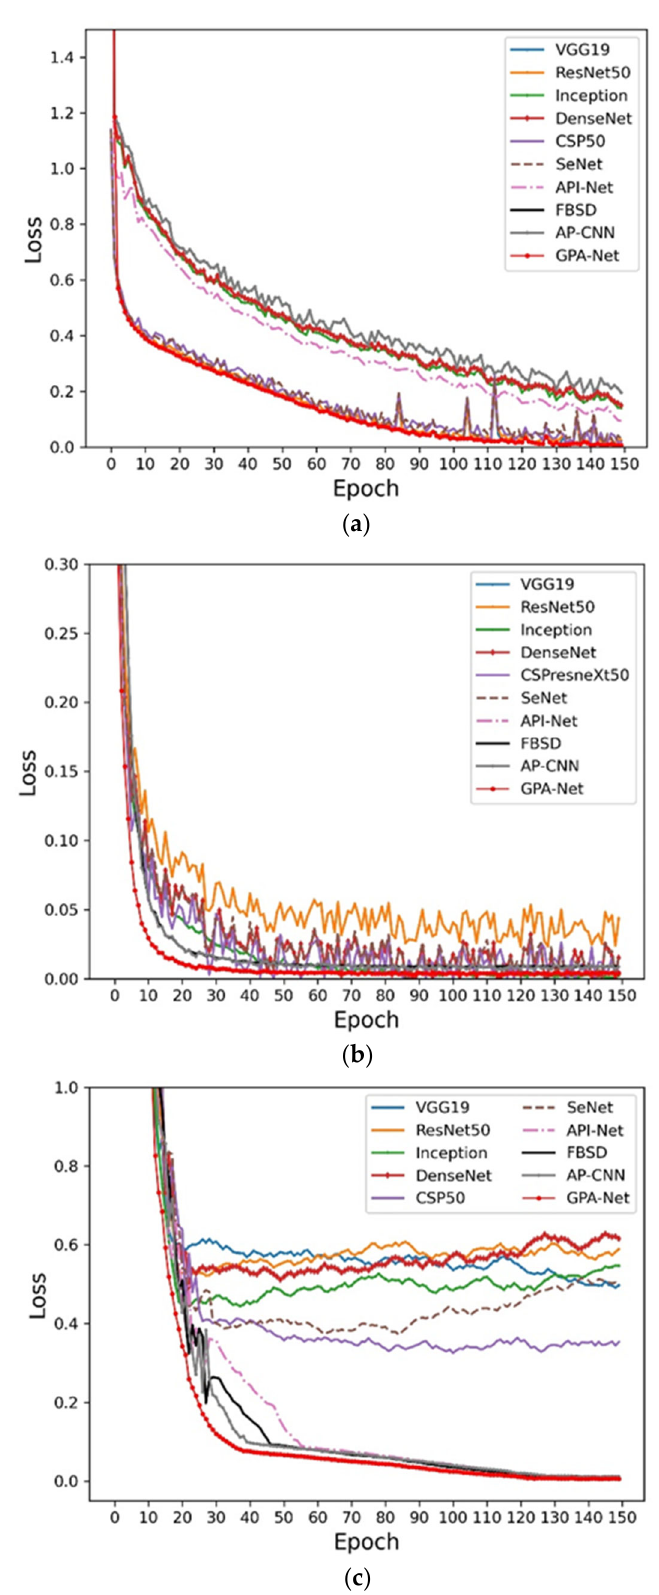
Figure 6. F1 scores for different models on different datasets.